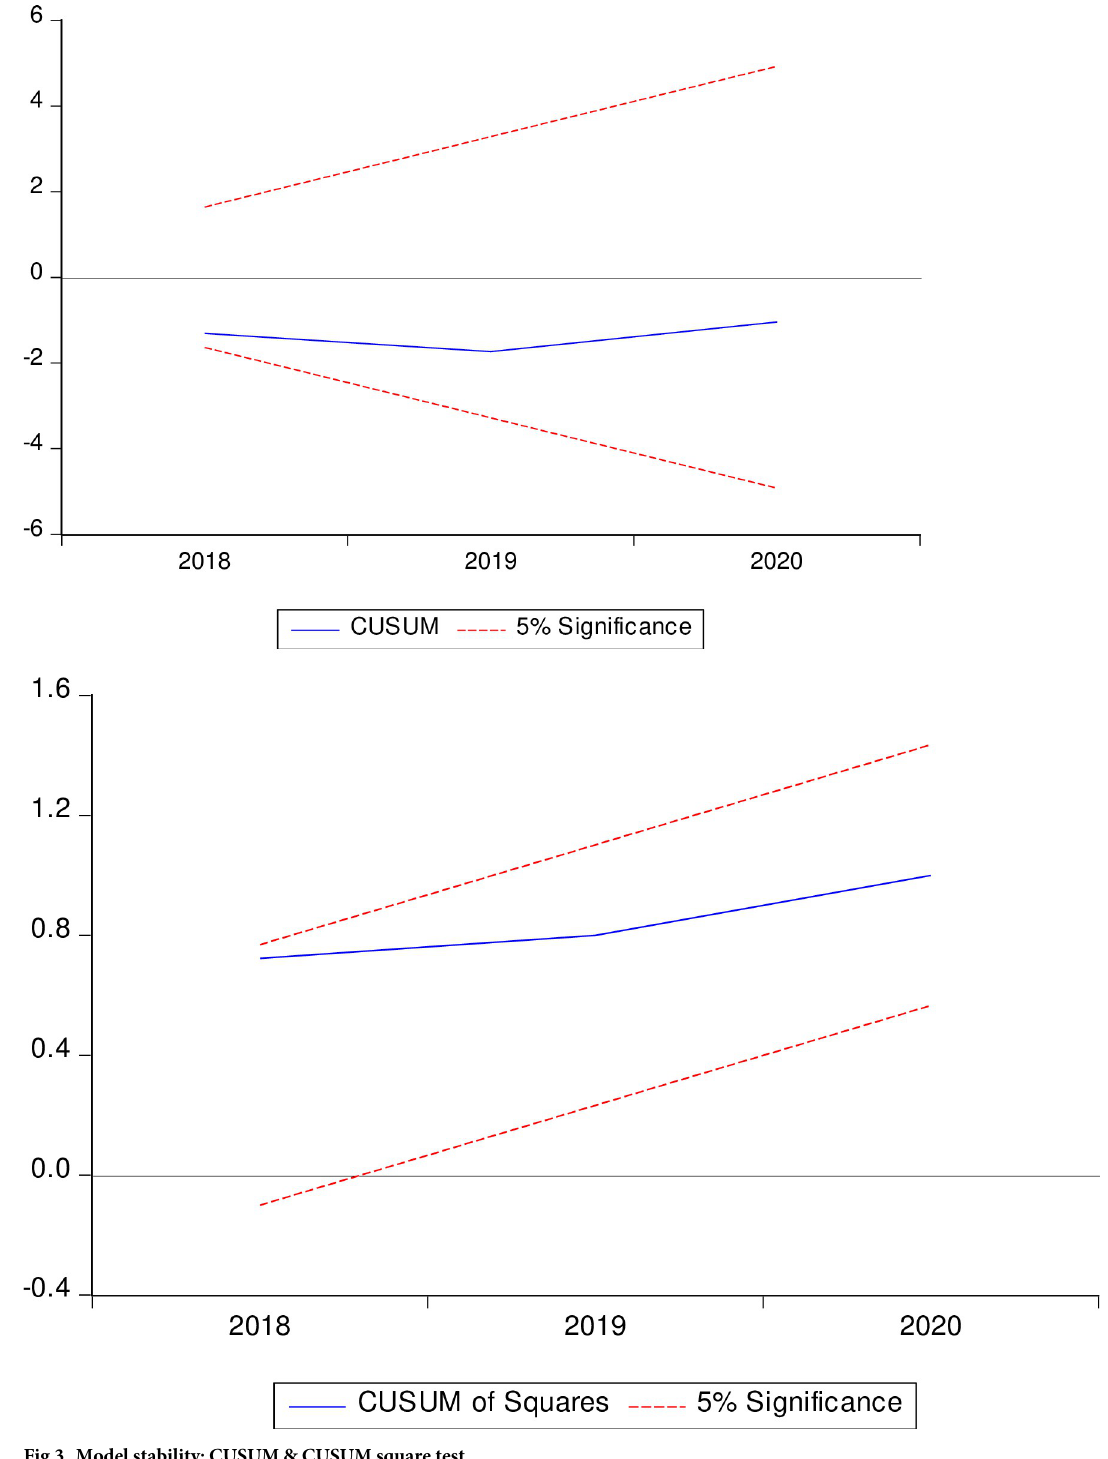
Fig 3. Model stability: CUSUM & CUSUM square